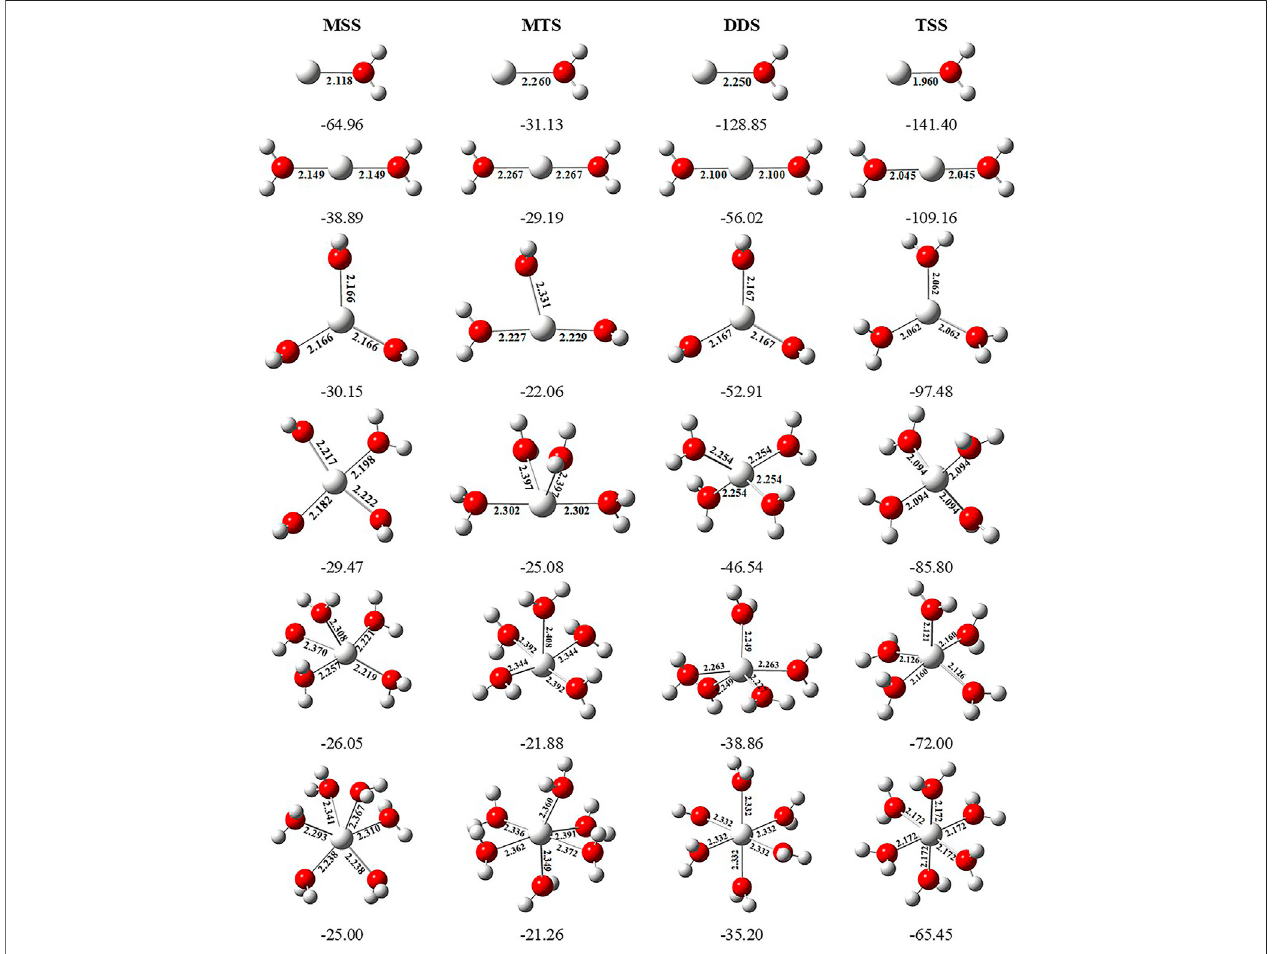
FIGURE 8 | Geometrical parameters (bond distances in angstrom) of the monocationic singlet state (MSS) and triplet state (MTS), dicationic doublet state (DDS), andtricationicsingletstate(TSS)ofSc z+ (OH 2 ) n ,wherez (cid:2) 1 – 3andn (cid:2) 1 – 6,ioncomplexes,obtainedattheMP2/6-31G*leveloftheory.Sequentialbindingenergy( Δ E seq ; kcal/mol) of these complexes obtained at the CCSD(T)/6-311G**//MP2/6-31G* level of